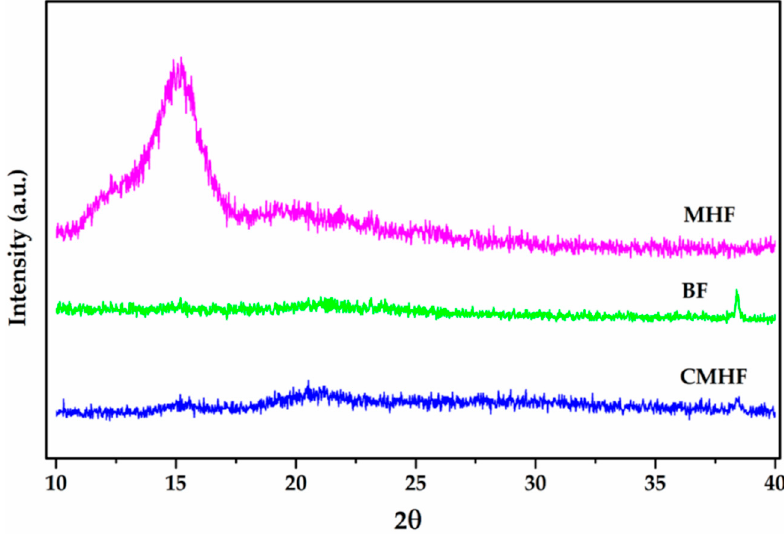
Figure 3. X-ray di ff raction (XRD) di ff ractograms of MHF, BF, and Figure 3. X-ray diffraction (XRD) diffractograms of MHF, BF, and CMHF.